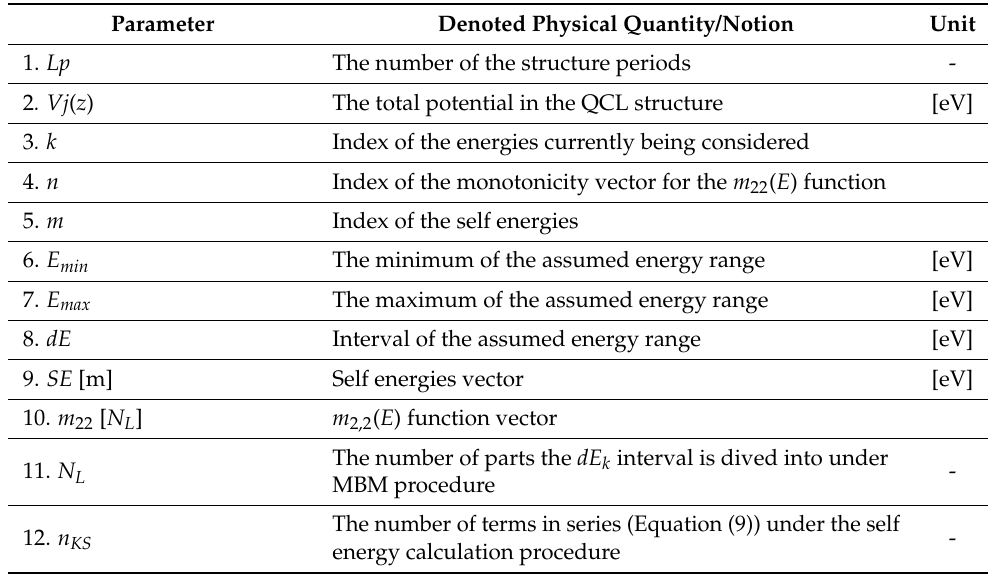
Figure 4. The algorithm of the Schrödinger equation solving process under the new approach to determining self energy. Table 1. Basic parameters and numerical procedures of the Schrödinger equation solving algo- rithm (see Figure 4).